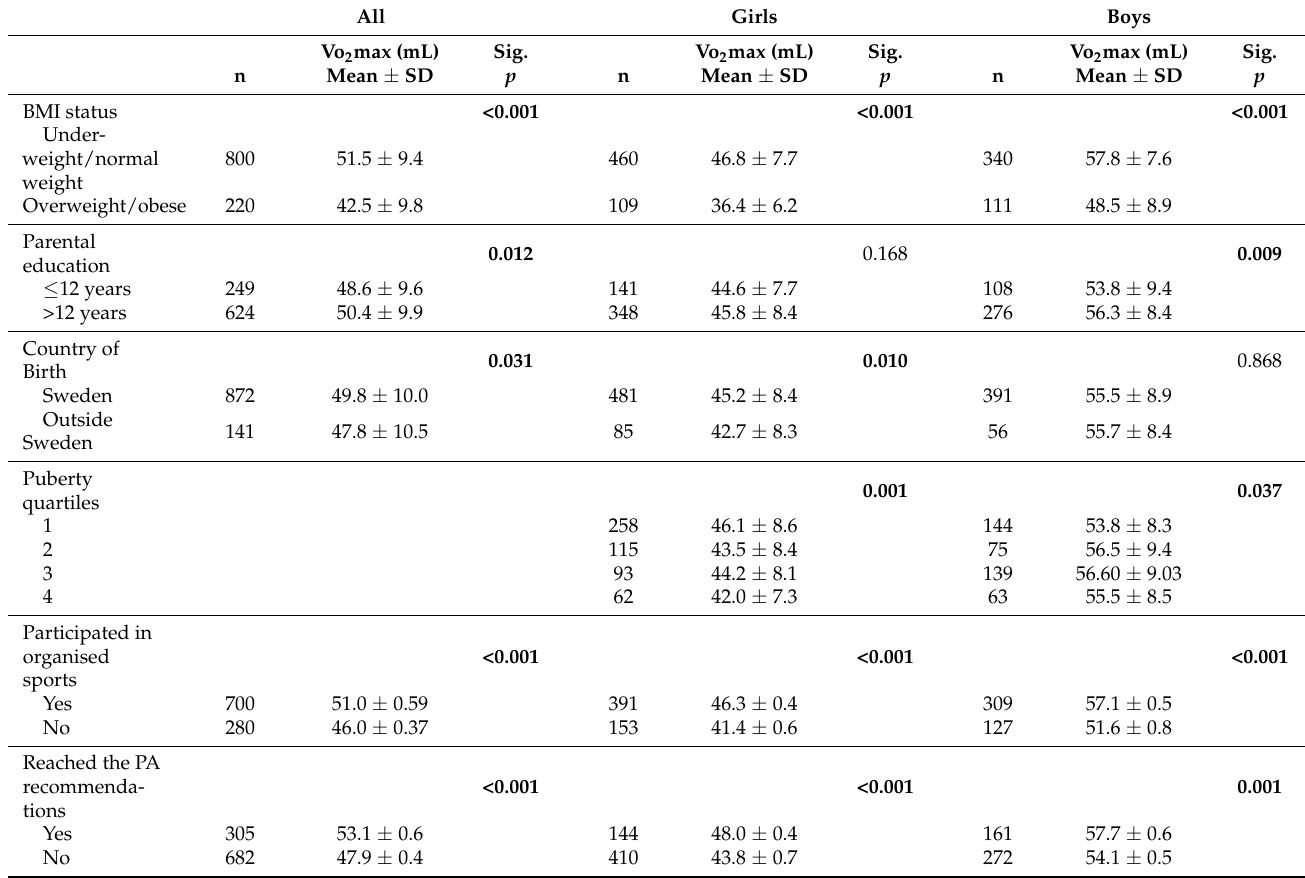
Table 2. Unadjusted mean fitness levels in different adolescent groups, stratified by gender. All Girls Boys Vo 2 max (mL) Sig. Sig. Vo 2 max (mL) Sig.